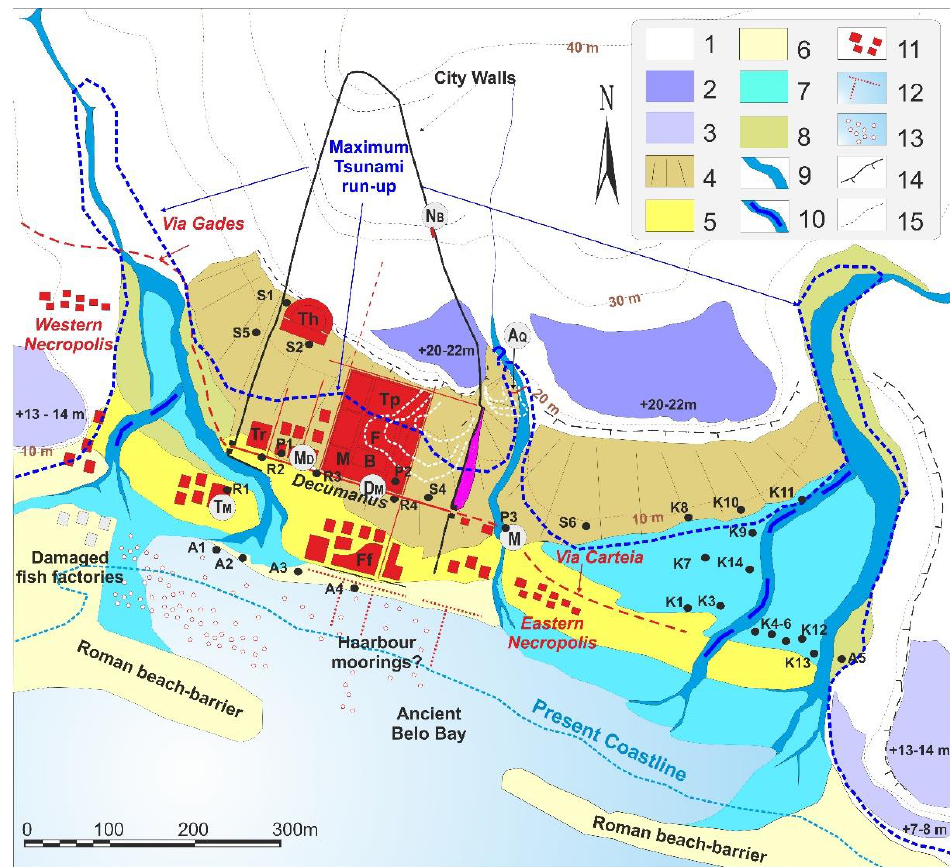
Figure 2. Paleogeography of Baelo Claudia (after [11,24]). (1) Betic Substratum (Almarchal Fm. Cretaceous–Eocene); (2) and (3) Pleistocene marine terraces; (4) Post-Roman colluvium; (5) Beach barrier (c. 4 ka BP); (6) Roman spit-bar and beach deposits; (7) Lagoon and river coastal floodplains; (8) Modern fluvial terraces; (9) Active channels; (10) Paleo-channels; (11) Roman buildings; (12) Har- bor moorings; (13) Submerged ashlars and blocks; (14) Scarps; (15) Flooded areas, late fourth cen- tury CE. S1 – S5, boreholes [9]; A1 – A5, sample sites [12]; R1 – R4, sample sites [10]; K1 – K11, boreholes